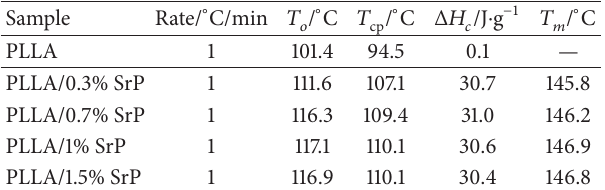
Table 1: DSC data of PLLA and PLLA/SrP samples at a cooling rate of 1 ∘